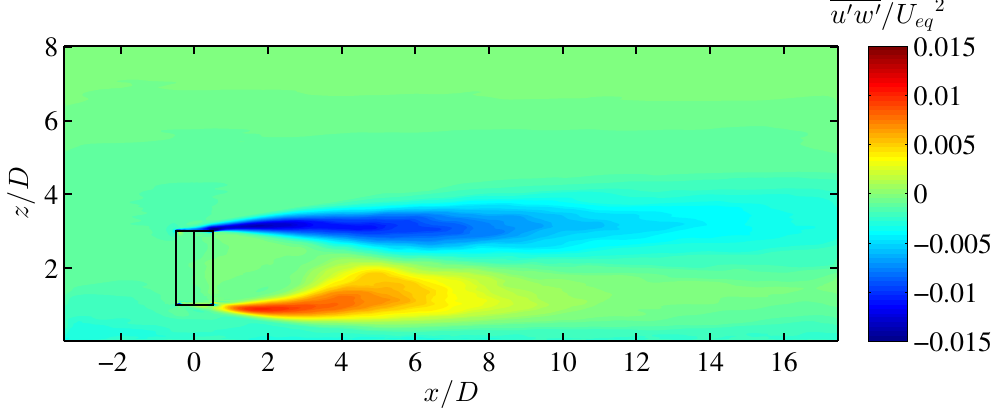
Figure 18. Contour plots of the normalized vertical turbulent flux, u (cid:48) w (cid:48) / U eq 2 , in the x − z plane going through the center of the turbine.